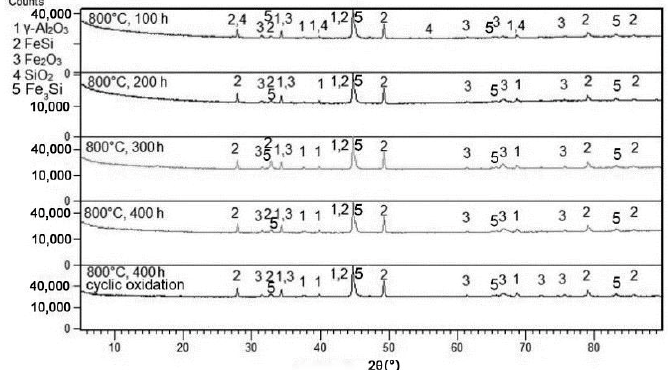
Figure 3. XRD patterns of FeAl20Si20 alloy after various durations of oxidation at 800 °C in air.